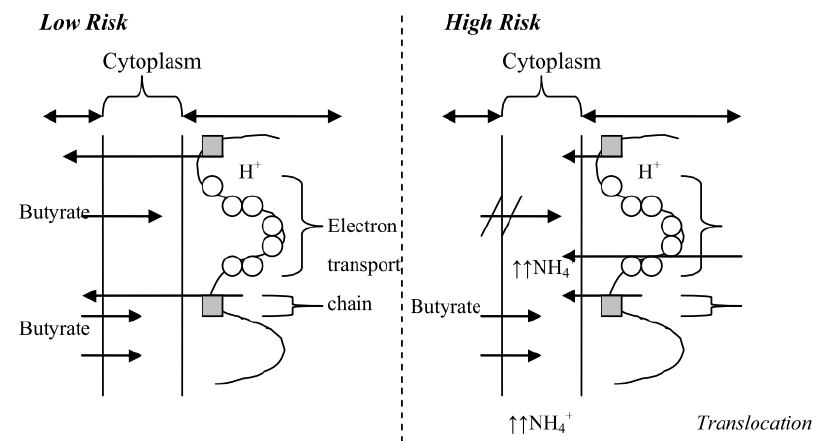
Figure 2. Cellular environment of low risk versus high risk of